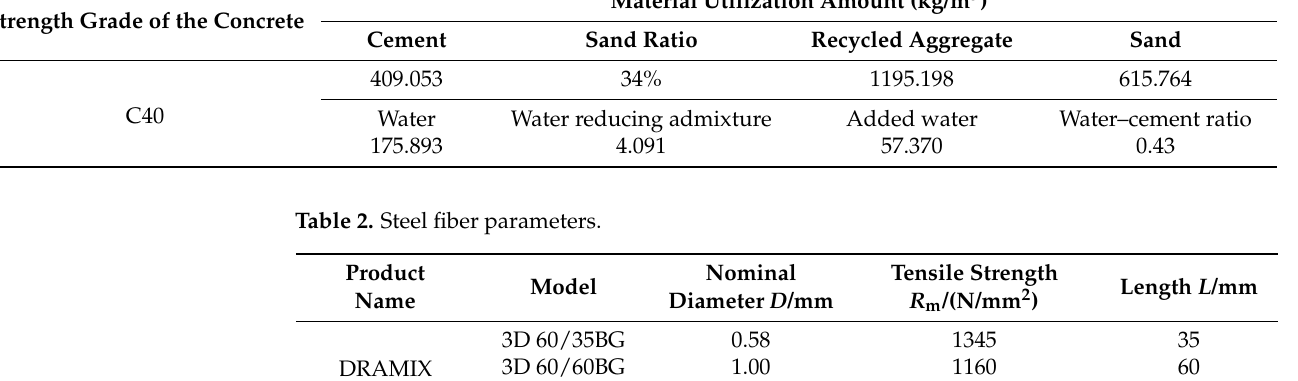
Table 1. Mixture design.